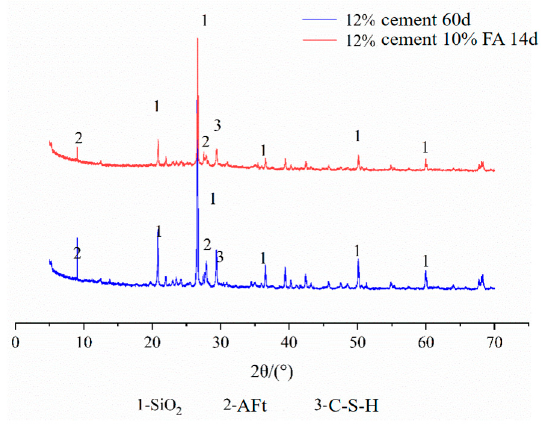
Figure 13. XRD diffraction pattern of FA cement–soil.